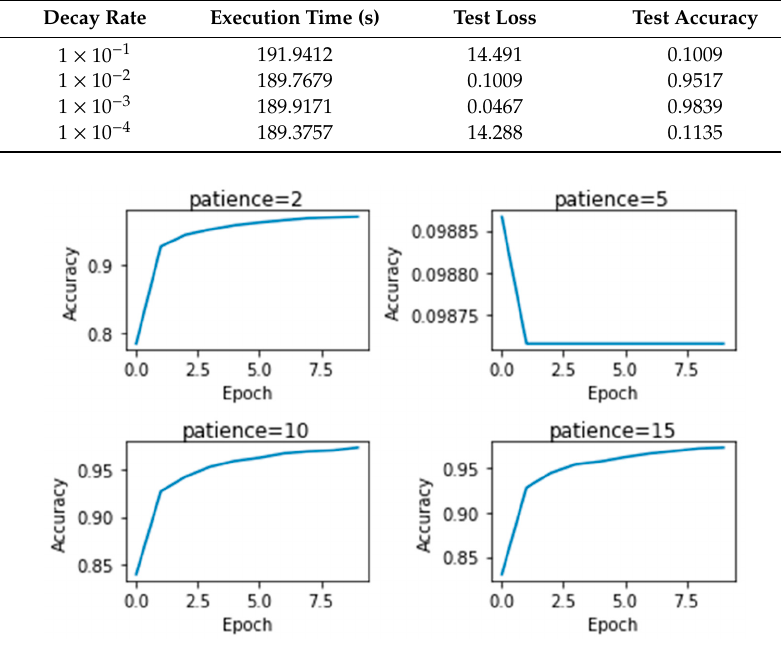
Figure 3. Effect of patience value on CNN. Figure 3. E ff ect of patience value on